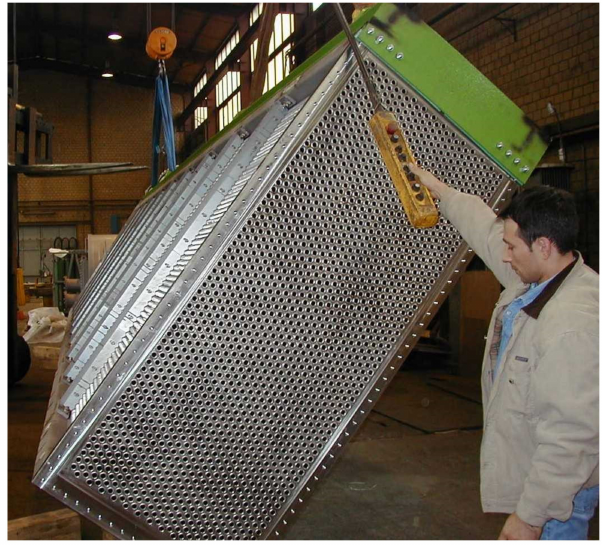
Figure 9. Superduplex heat exchanger with seal welded tube plate to handle seawater with a high sand